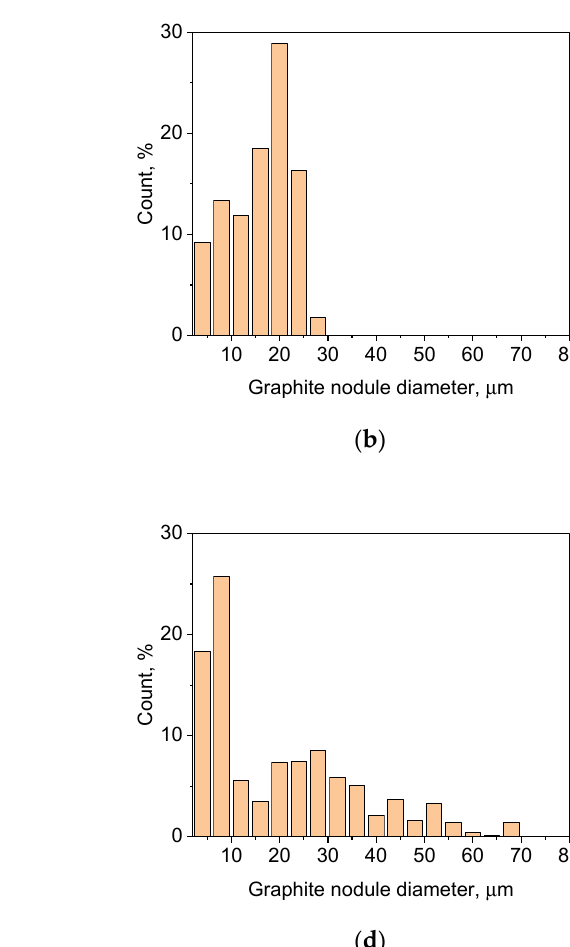
Figure 8. Graphite particle size distribution: ( a ) casting with wall thickness of 3 mm; ( b ) 5 mm; ( c ) 13 mm; ( d ) 25 mm.